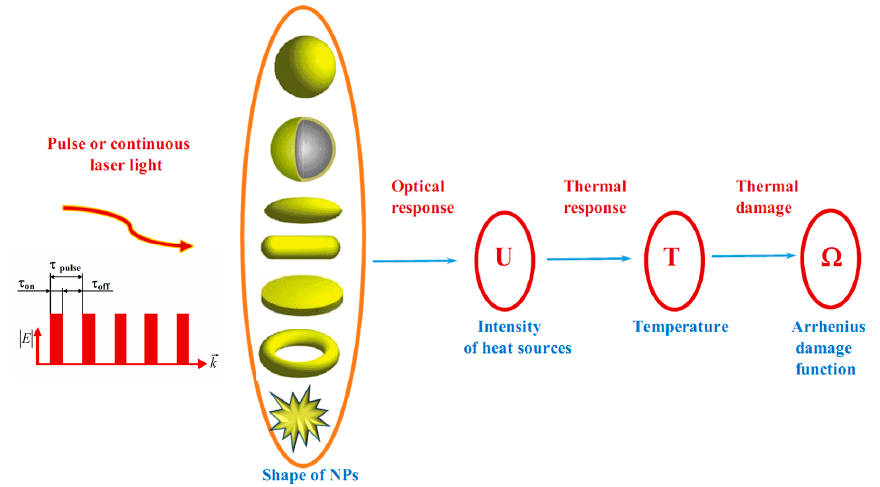
Figure 2. The general scheme of mathematical modeling of nanoparticle mediated laser photothermal treatment of cells or tissues. Here U = ε″ω | E | 2 /8 π is the local value of intensity of heat sources caused by the absorption of laser radiation(see, e.g., [55]); ε″ is the imaginary part of dielectric constant of NP, ω and E are the angular frequency and the local value of electric field amplitude diffracted into NP, respectively.